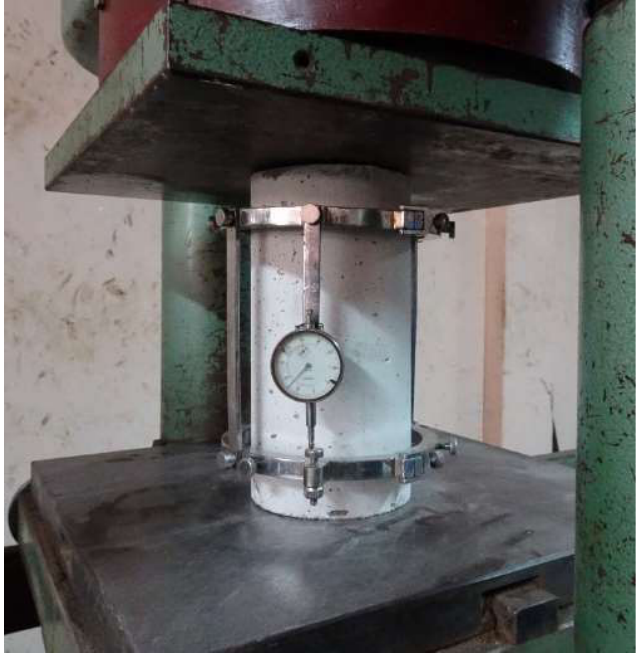
Figure 3. Modulus of elasticity test setup.